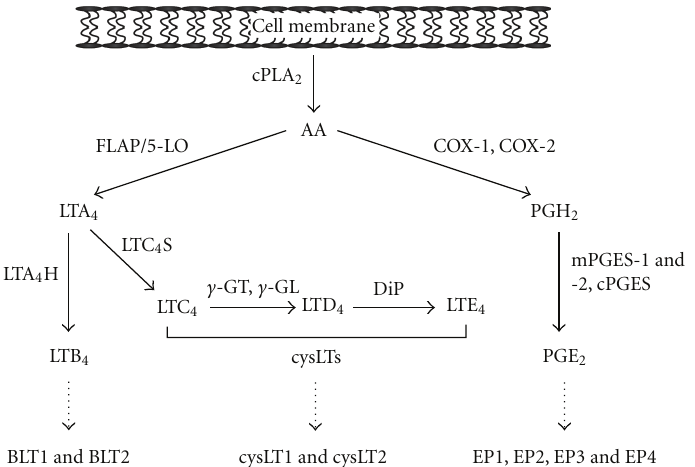
Figure 1: Synthesis of PGE 2 and the leukotrienes. cPLA 2 —cytosolic phospholipase A 2 , AA—arachidonic acid, FLAP—5-lipoxygenase activating protein, 5-LO—5-lipoxygenase, LTA 4 —leukotriene A 4 , LTA 4 H—leukotriene A 4 hydrolase, LTB 4 — leukotriene B 4 , BLT1 and BLT2—B leukotriene receptor 1 and 2, LTC 4 S—leukotriene C 4 synthase, LTC 4 —leukotriene C 4 , γ -GT- γ -glutamyl transpeptidase, γ -GL- γ -glutamyl leukotrienease, LTD 4 —leukotriene D 4 , DiP—dipeptidase, LTE 4 —leukotriene E 4 , cysLTs—cysteinyl leukotrienes, cysLT1 and cysLT2—cysteinyl leukotriene receptor 1 and 2, COX-1 and COX-2—cyclooxygenase 1 and 2, PGH 2 —prostaglandin H 2 , mPGES-1 and -2—microsomal prostaglandin E synthase-1 and -2, PGE 2 —prostaglandin E 2 , EP1-4—E prostanoid receptors 1–4.